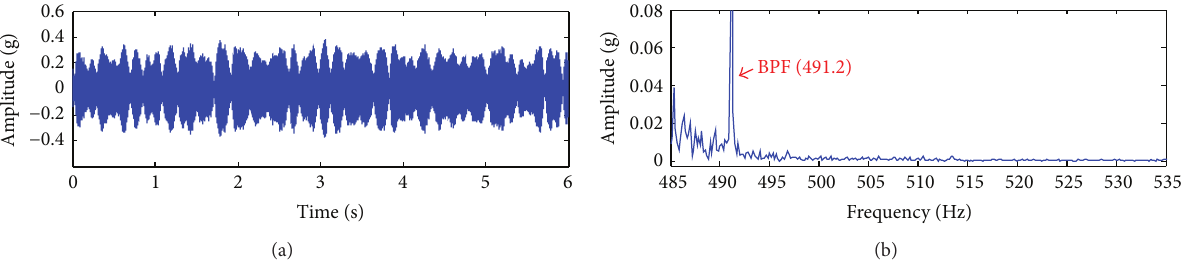
Figure 16: Output signals of the ASR method under normal condition: (a) time-domain waveform and (b) frequency